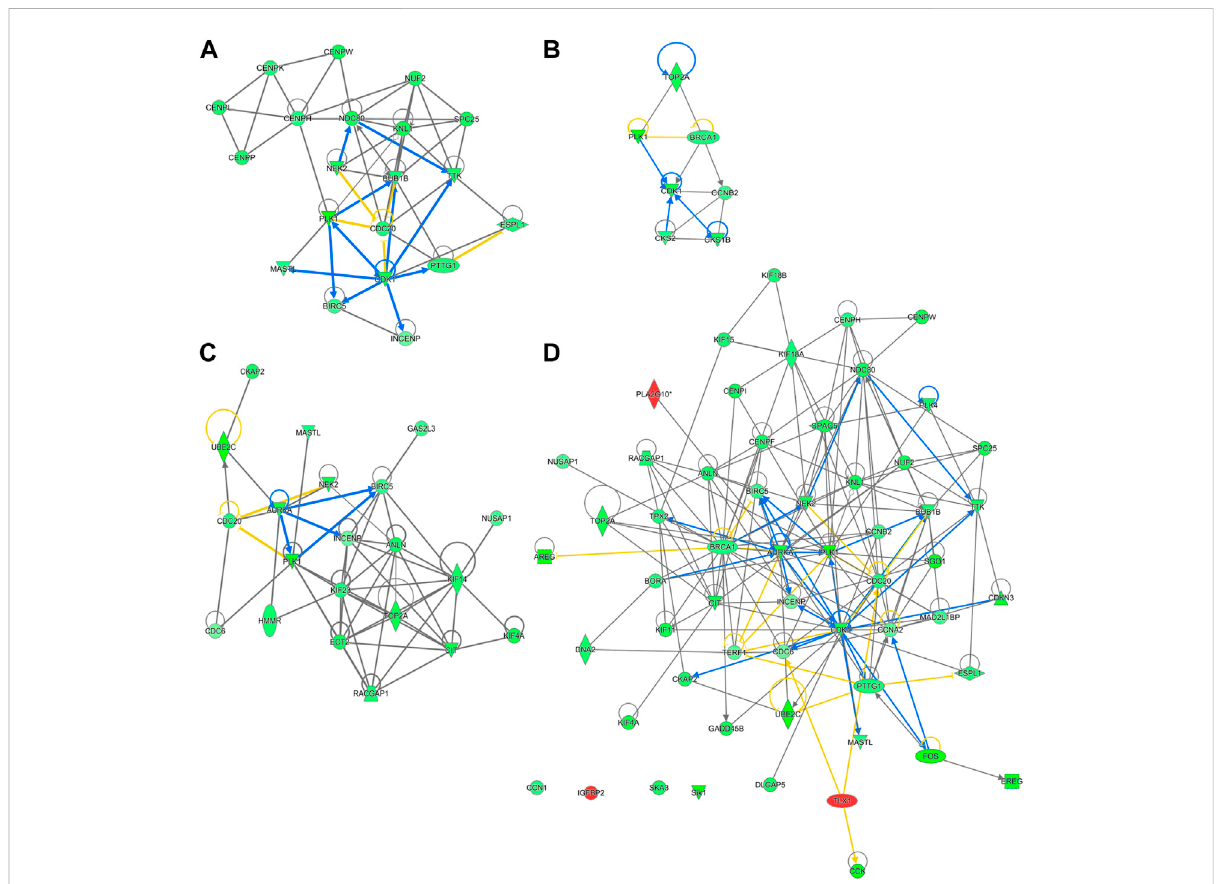
Network mapping of differentially expressed genes between DLY and FED chicks. Many genes associated with cell cycle progression and mitosisarealtered(fold-change ≥ 5;FDR p -value ≤ 0.05)inDLYchickscomparedtotheirFEDcounterparts,includingthoseinvolvedin (A)